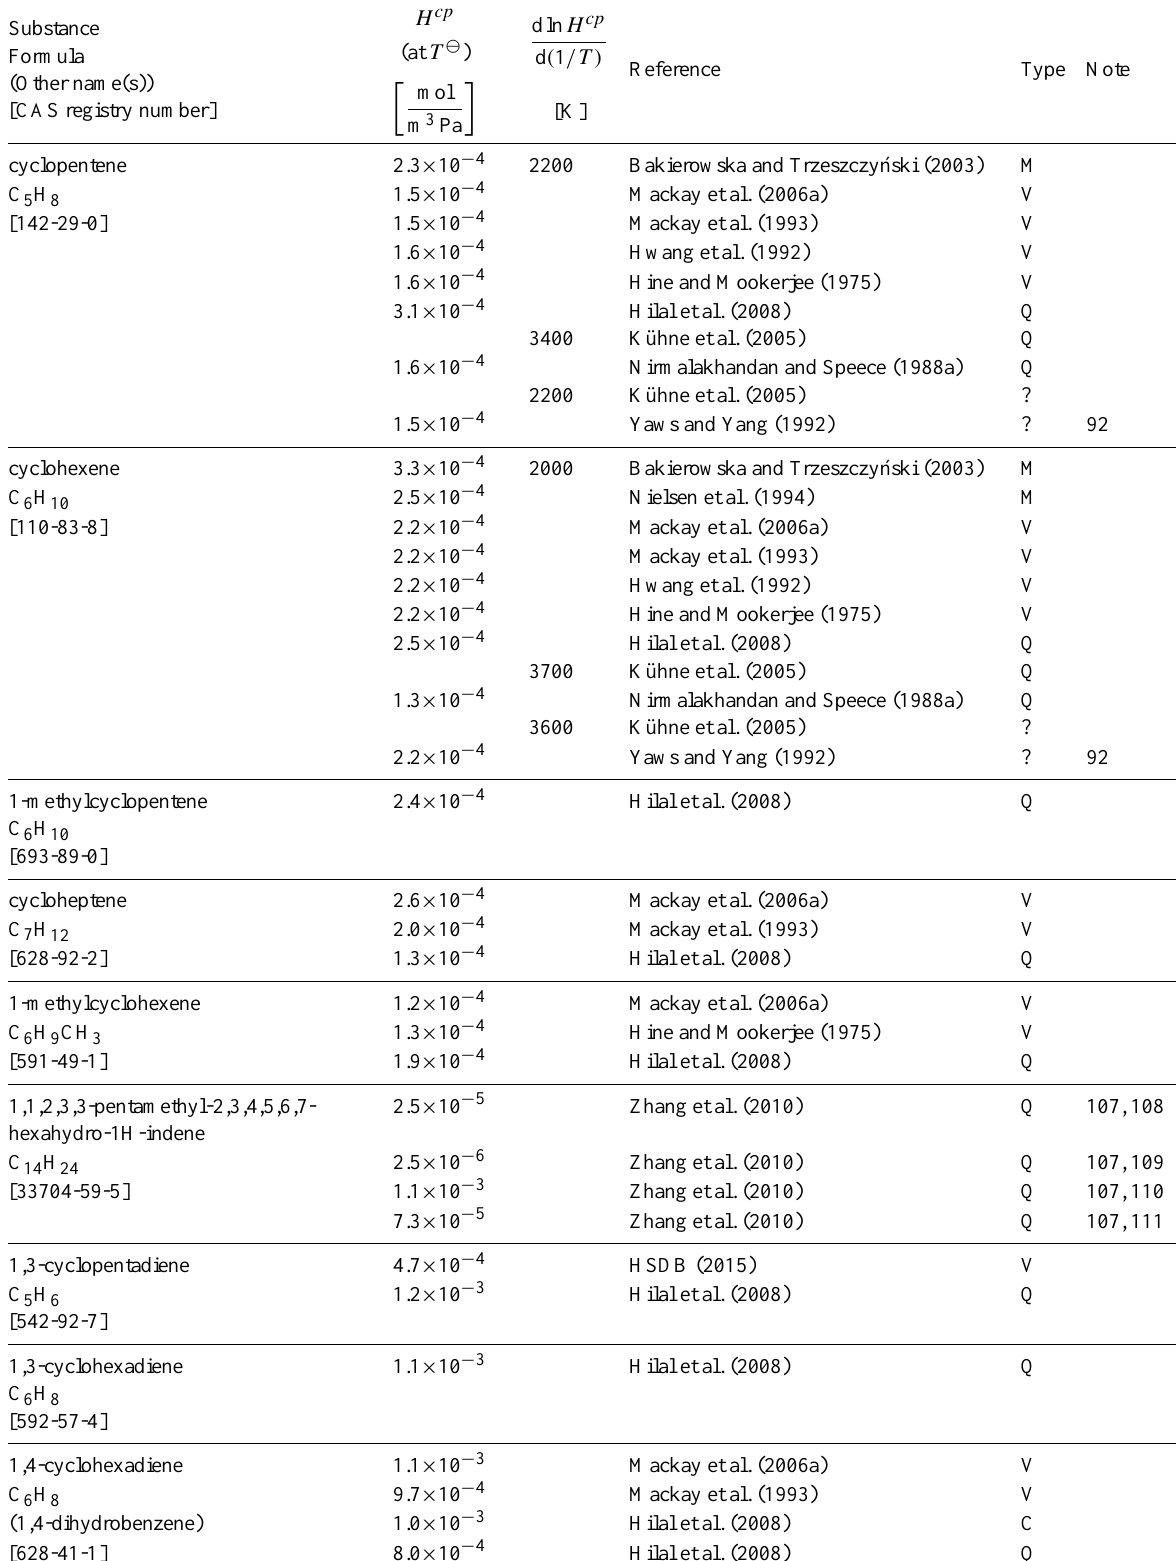
Table 6: Henry’s law constants for water as solvent